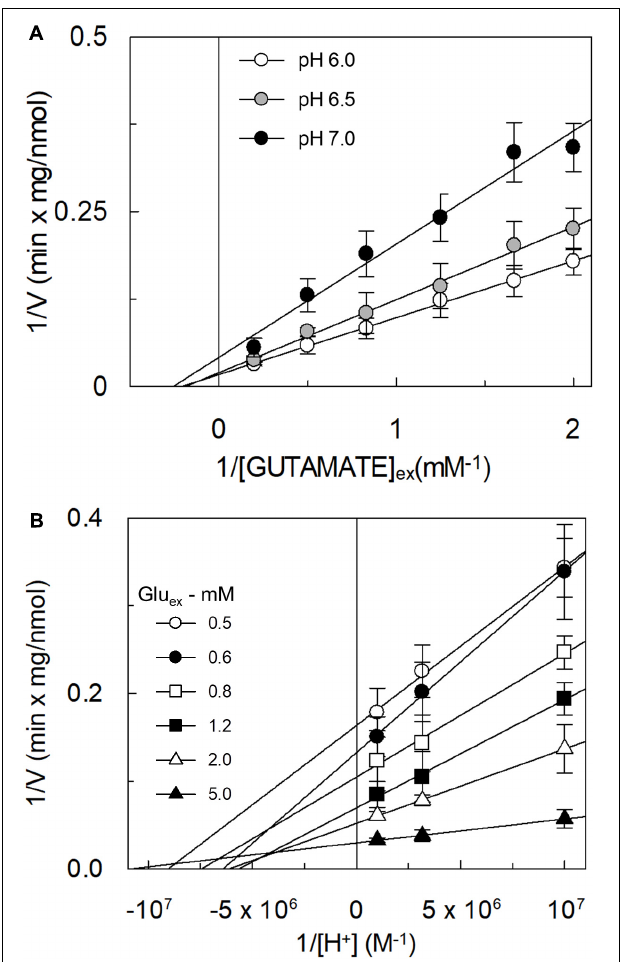
FIGURE 6 | Effect of (cid:49) pH on glutamate transport by hASCT2 reconstituted in proteoliposomes. Purified hASCT2 was reconstituted in proteoliposomes as described in materials and methods, buffered at the indicated intraliposomal pH (in). The transport assay was started by adding 50 mM Na-gluconate and 500 µ M of [ 3 H]glutamate (A) or 50 µ M of [ 3 H]glutamine (B) prepared at the indicated pH (ex). The transport was measured in 60 min according to the stop inhibitor method. The transport rate was expressed as nmol/mg in 60 min. Results are means ± SD from three independent experiments. *Significantly different from the control sample (pH 7.0 in /7.0 ex ) as estimated by Student’s t -test ( P <